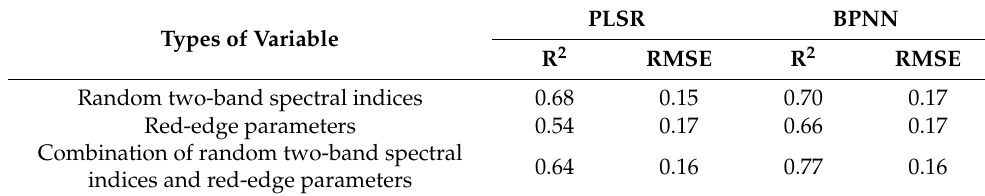
Table 5. Estimation model of CNC based on the combination of multiple spectral parameters.